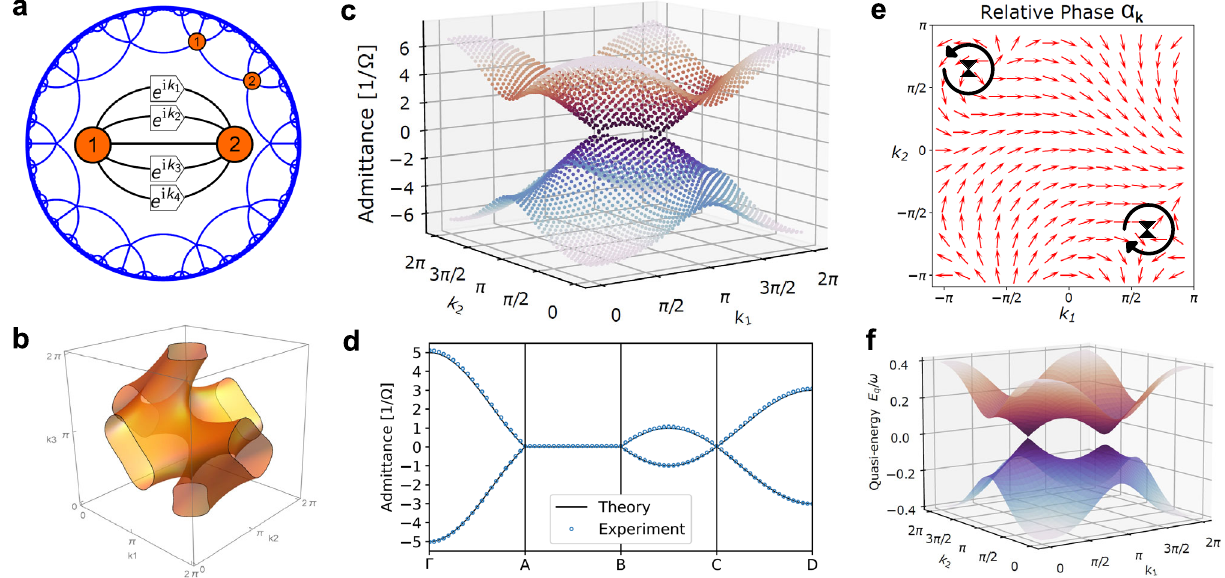
Fig.4|Hyperbolicgraphene. ThiscollectionofBlochwavesonthehyperbolic{10, 5} lattice features many properties of its Euclidean counterpart, but with a hyper- bolic twist. It is a topological semimetal with four-dimensional momentum space andcrystalmomentum k =( k 1 , k 2 , k 3 , k 4 ). a Twositesintheunitcellwith fi venearest neighbors comprise the unit-cell circuit that we realize experimentally with topo- lectrics. b Two-dimensional nodal surface S of gapless Dirac excitations with energy ∣ h ( k ) ∣ =0, projected onto the ( k 1 , k 2 , k 3 )-hyperplane. c Experimentally measured Dirac cones in the plane k =( k 1 , k 2 , 2 π /3, 0) as a function of k 1 and k 2 . d Experimentally measured spectrum along path through k -space. The labels Γ , A, B, C, D correspond to the Brillouin zone points (0, 0, 0, 0), (2 π /3, − 2 π /3, 0, π ),